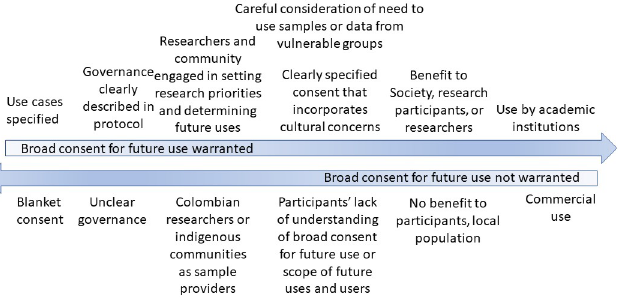
Fig 1. Facilitators and barriers related to ethics review committee members consideration of broad consent for future use of data and samples in research protocols.